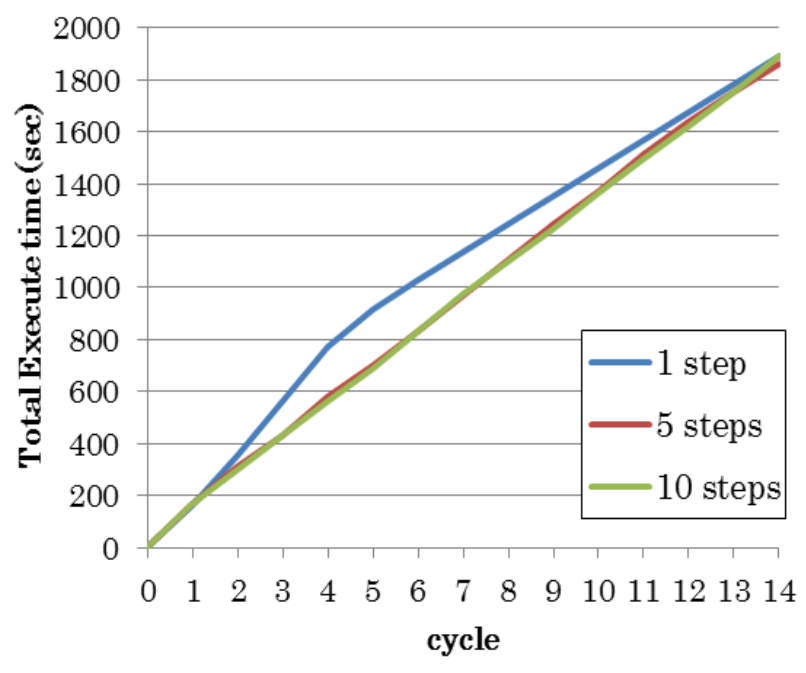
Fig. 7. magnification of Fig.